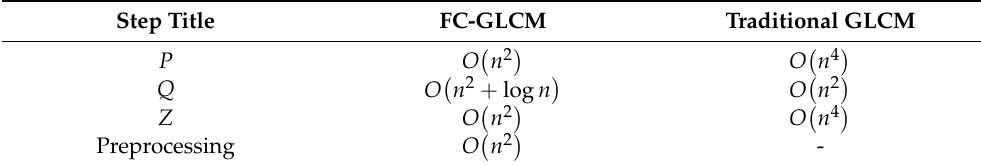
Table 1. Comparison of the temporal complexity of FC-GLCM with traditional